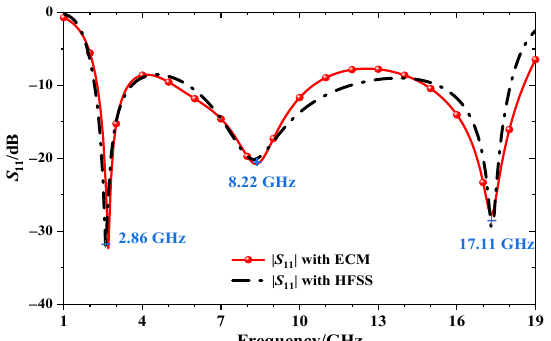
Figure 3. Comparison of reflective coefficients simulated by CST and calculated by ECM. Table 1. Optimized values of ECM and physical size components for absorbers.